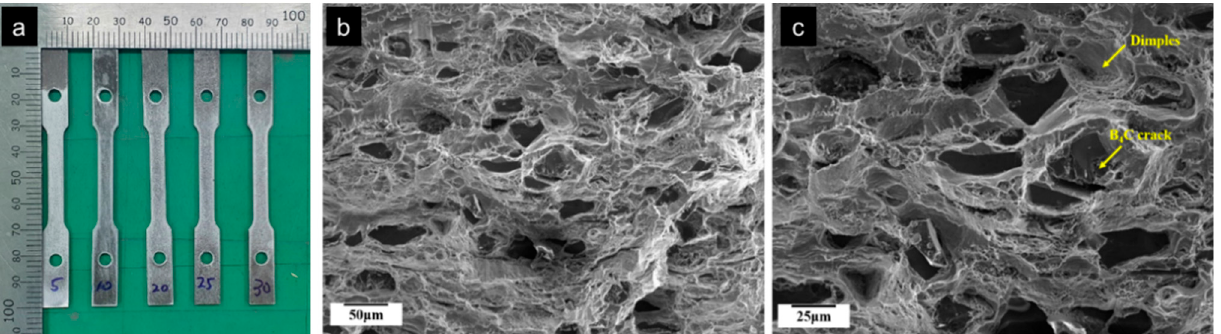
Figure 7. ( a ) Photograph of tensile specimens (sub-size ASTM E8) and ( b , c ) SEM images of tensile fracture surface of hot-rolled B 4 C/Al6061 composites.